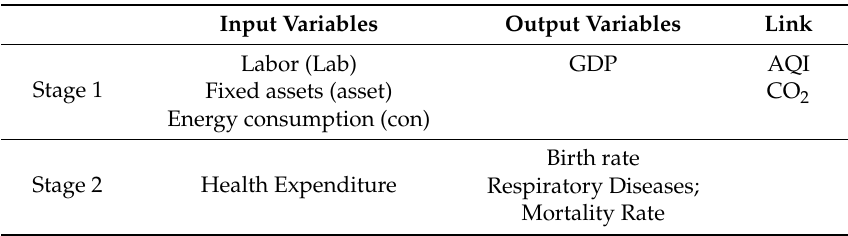
Table 1. Input and output variables.